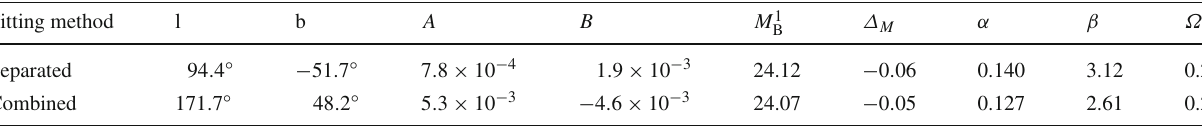
Table 3 Fitted parameters of JLA data set for separated fitting and combined fitting Fitting